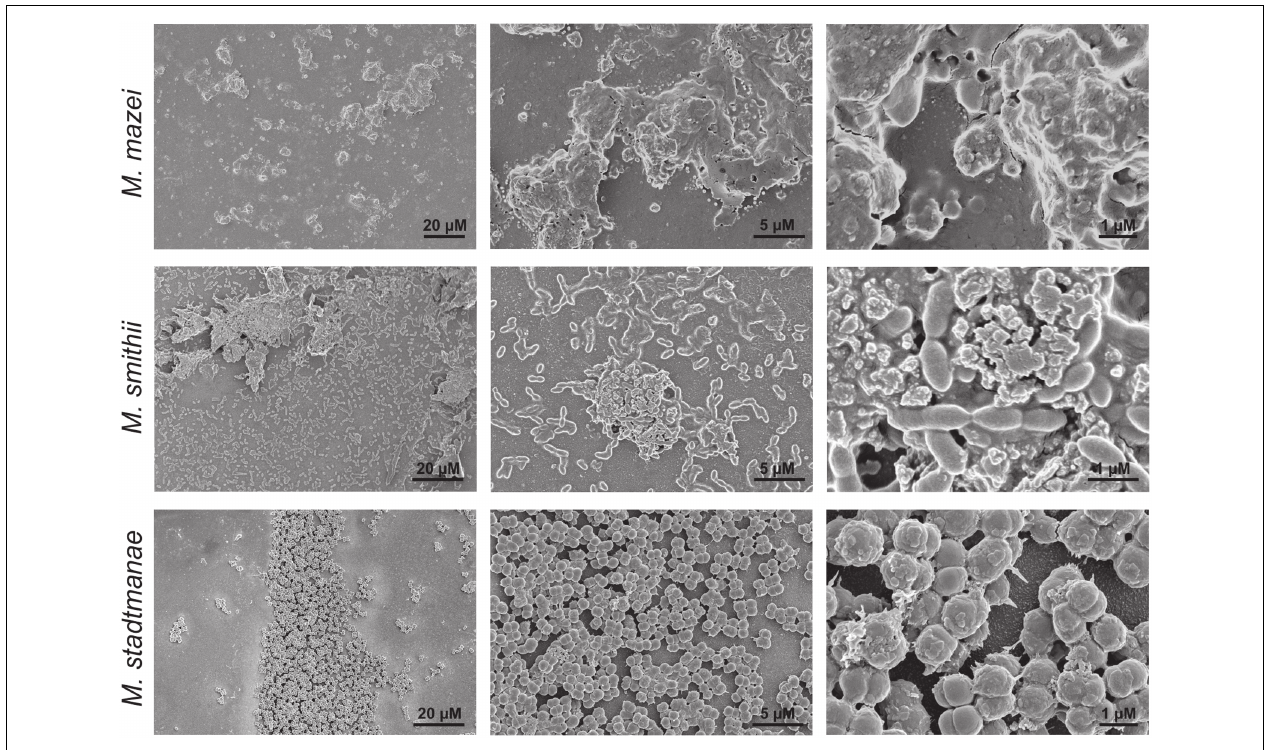
FIGURE 3 | Growth of methanogens on mica examined by SEM. Methanosarcina mazei , Methanobrevibacter smithii, and Methanosphaera stadtmanae were grown on mica in hungate tubes with 3 ml of the respective medium. After 48 h